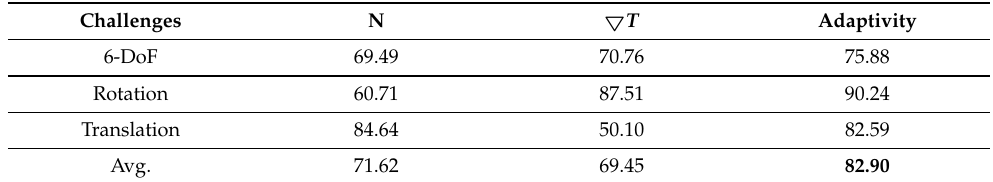
Table 6. Using the Success Plot metric for comparison in an ablation study, and the best results are highlighted bold-faced.